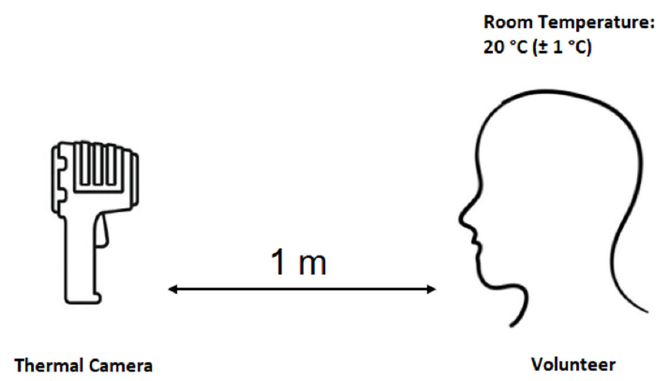
Figure 2. Experimental setup of thermal image capturing.